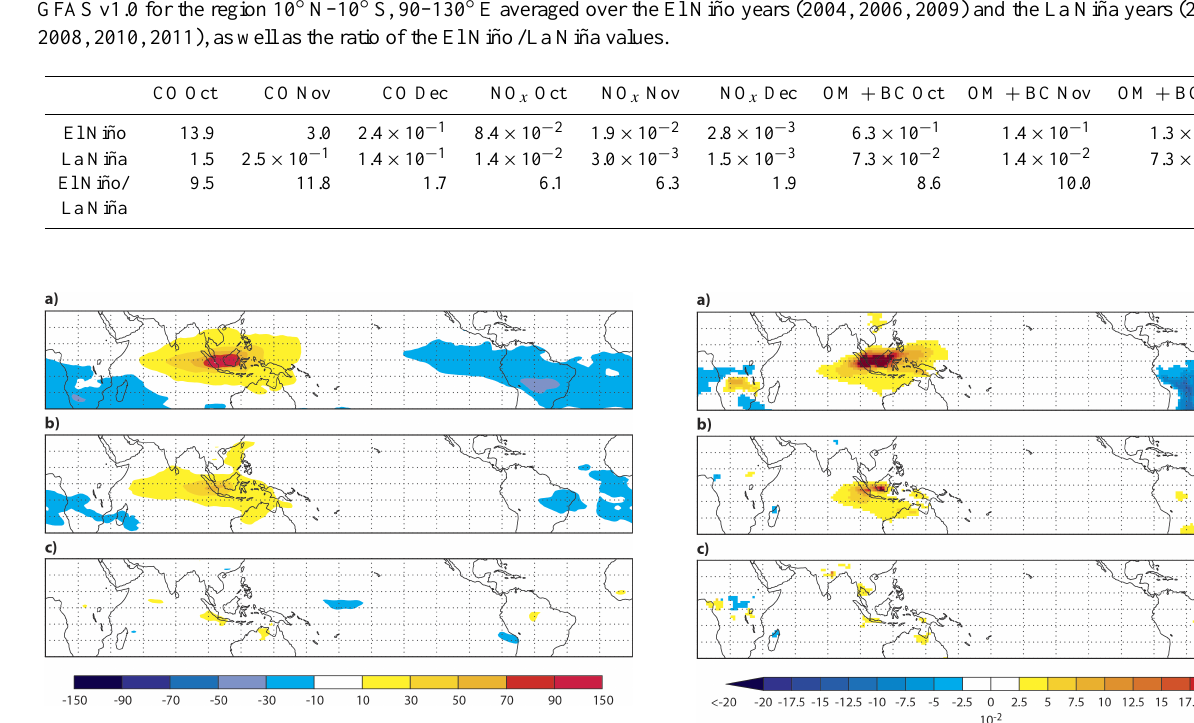
Table 1. Biomass burning emissions in Tg per month for CO, NO x , and the smoke aerosols (sum of organic matter and black carbon) from